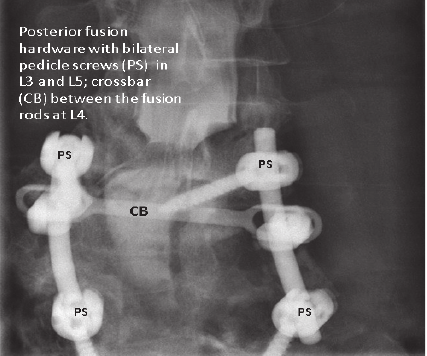
Figure 3: Surgical changes include posterior fusion hardware with bilateral pedicle screws in L3 and L5; crossbar between the fusion rods at